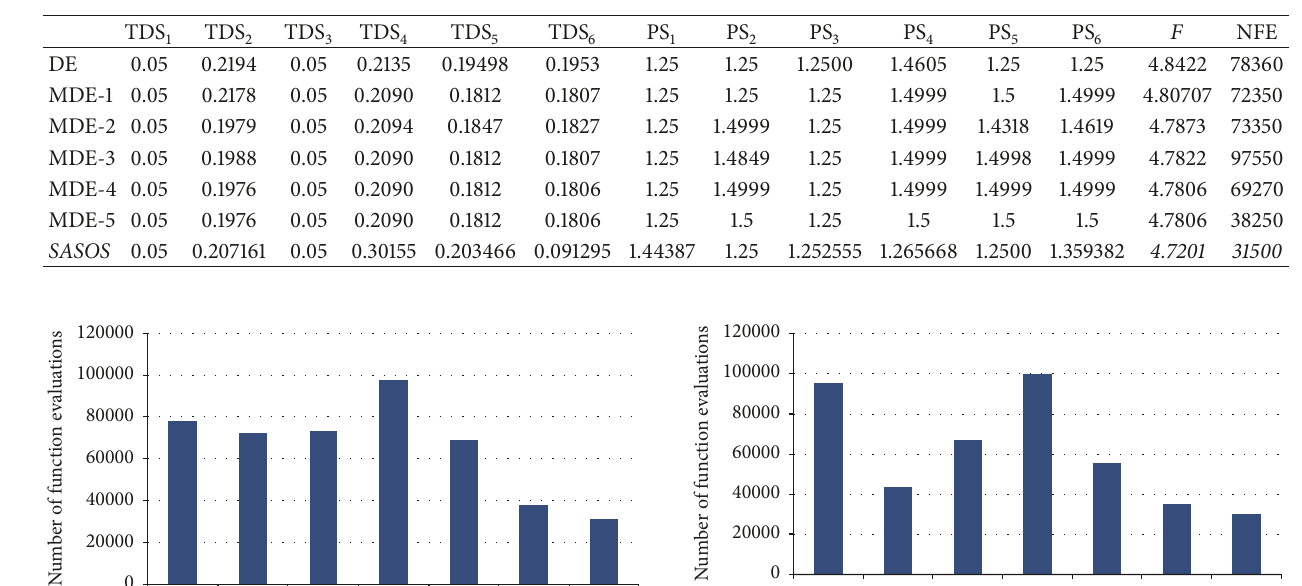
Table 1: Optimal values of design variables, objective values, and function evaluations obtained by SASOS, DE, and modified DE: IEEE 3-bus system.